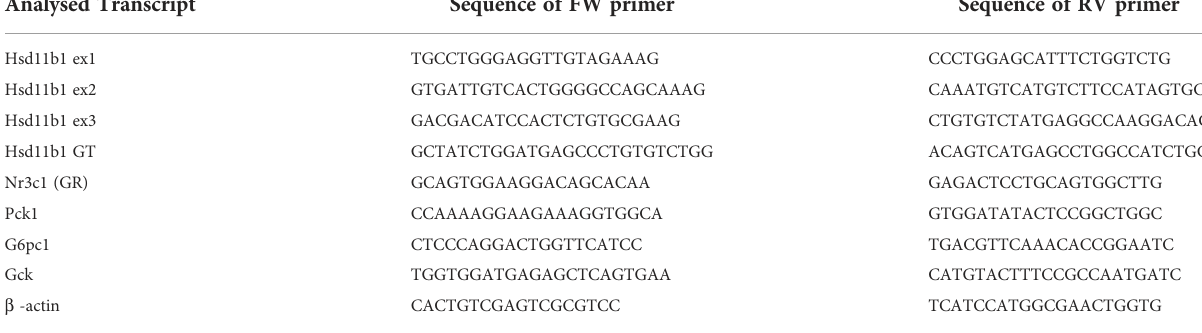
TABLE 1 Primers Used for the Quantitative Detection of Hsd11b1, Nr3c1, Pck1, G6pc2 normalised to b − actin. Analysed